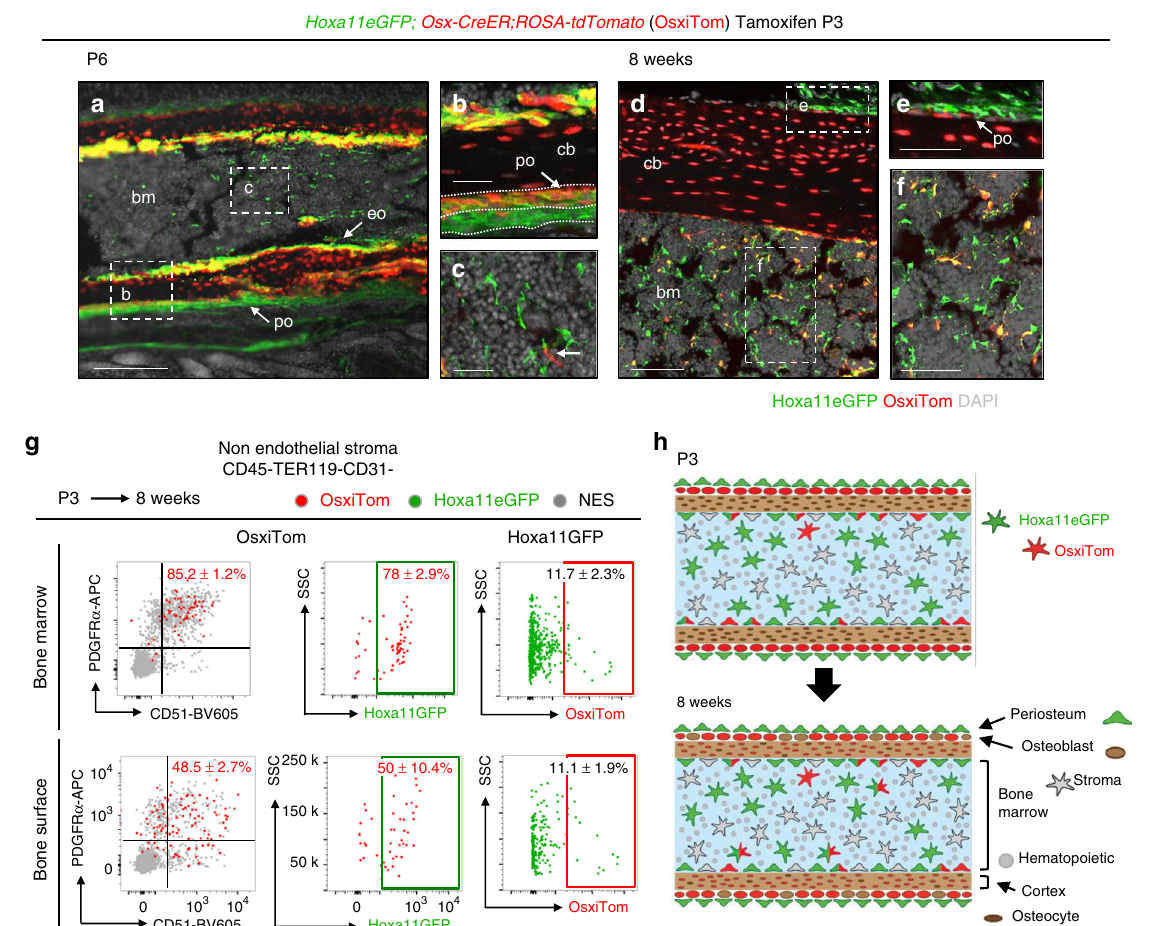
Fig. 8 Hoxa11eGFP-positive MSCs are distinct from embryonic Osx- lineage. Comparison of Hoxa11eGFP (green) and Osx-CreER lineage-marked cells (OsxiTom, red) was performed in Hoxa11eGFP;Osx-CreER;ROSA-tdTomato mice. a – i Pregnant females received tamoxifen at E13.5 and co-expression of Hoxa11eGFP and embryonic Osx -lineage was examined at ( a , b ) E14.5, ( c , d ) E18.5, and ( f – i ) 8 weeks. a Complete radius (r) and ulna (u) 24 h after tamoxifen with proximal to the left and distal to the right. White box region magni fi ed in ( b ) anlagen boundary indicated by dotted white line. c Mid- diaphysis ulna; white dashed boxes indicate magni fi ed region of ( d ) primary spongiosa and ( e ) periosteum. f Mid-diaphysis tibia; white dashed boxes indicate magni fi ed region of adult ( g ) endosteal surface and ( h ) bone marrow. ( i ) Flow cytometry analysis of non-hematopoietic, non-endothelial stroma (CD45-TER119-CD31-, NES) in bone marrow (top panels) and bone adherent (bottom panels) compartments. First panel: analysis of OsxiTom population for PDGFR α /CD51, second panel: analysis of OsxiTom for Hoxa11eGFP, third panel: analysis of Hoxa11eGFP-positive cells (green) for OsxiTom expression. OsxiTom cells are very rare (0.018 ± 0.03 of total NES) on bone surface (lower left panel). ( n = 3). ‘ n ’ represents pooled cells from the radius and ulna of one forelimb of biologically independent animals. Flow cytometry dot plots, gray dots: total non-endothelial stroma (NES). Data presented as mean ± standard deviation. j Diagrammatic representations of data. k Pregnant females received tamoxifen at E11.5 and Hoxa11-CreER T2 ;ROSA-tdTomato embryos were analyzed at ( k , l ) E14.5 and ( m – p ) E18.5. k White boxed region shown in inset, co-expression of Hoxa11iTom (red) and Osterix (green). ( m ) white boxed region of primary spongiosa magni fi ed in n . n White dashed boxes indicate magni fi ed regions of ( o ) trabeculae and ( p ) periosteum. Periosteum: po, bone marrow: bm, cortical bone: cb, endosteum: endo All fl uorescent images, gray: DAPI. Scale bars: ( a , f , k ) 200 μ m, ( b , d – e , g – h ) 50 μ m, ( c , i , n ) 100 μ m,